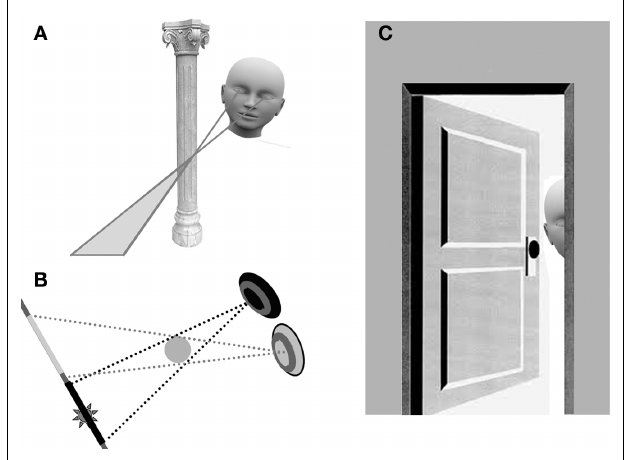
FIGURE 1 | Graphic depictions of a differential occlusion of two eyes (A,B) and a selective obstruction of just one eye